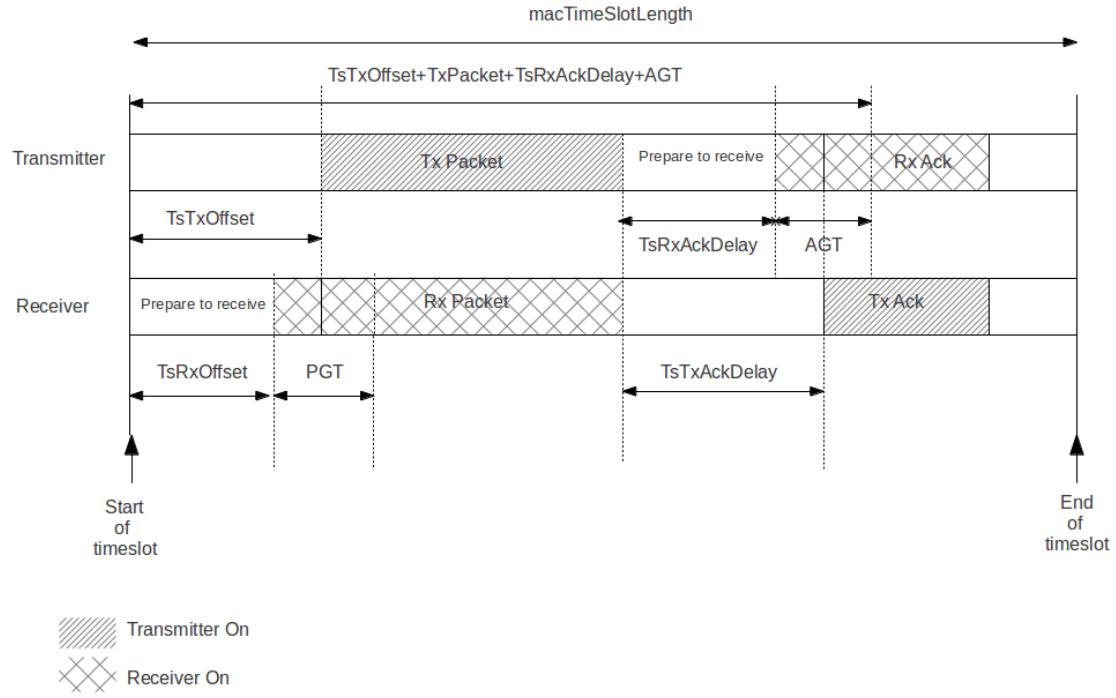
Figure 2. IEEE 802.15.4e time slot template. This defines the sequence of actions that take place in a time slot in both the sender and receiver